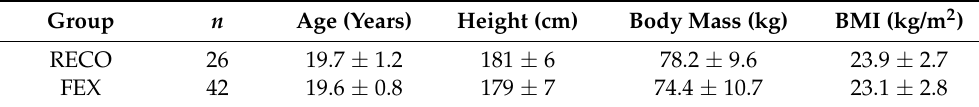
Table 1. Characteristics of participants in the RECO and FEX groups at baseline. Values are the means ± SD. No statistically significant differences between the groups were